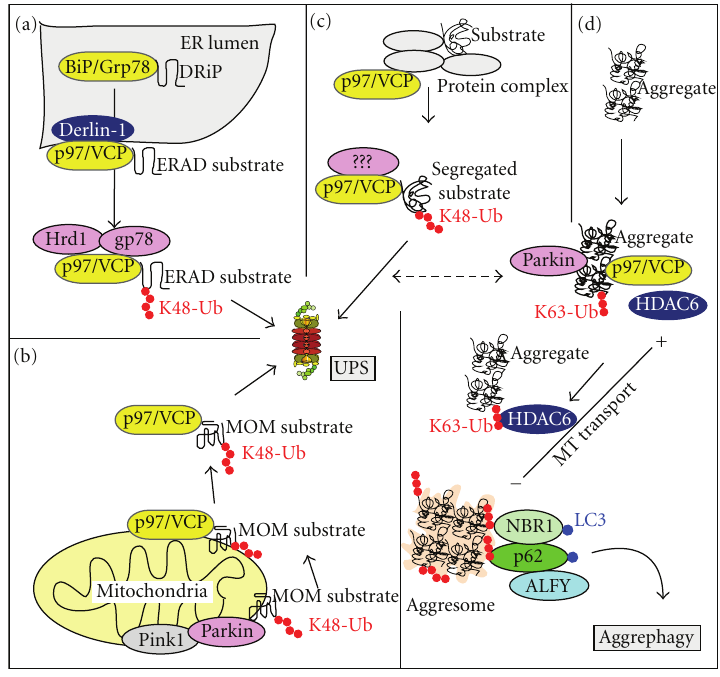
Figure 3: Protein degradation assisted by p97/VCP and HDAC6. (a) Misfolded substrates located in the ER lumen or at the ER membrane are recognized by the ER luminal Hsp70 homologue BiP/Grp78 and degraded by ER-associated degradation (ERAD). A complex of p97/VCP and Derlin-1 mediates the transport of ERAD substrates into the cytoplasm where they are ubiquitinated by E3 ligases such as Hrd1 and gp78 and degraded by the UPS. (b) p97/VCP mediates the segregation of ubiquitinated mitochondrial outer membrane (MOM) substrates into the cytoplasm, where they are degraded by the UPS. (c) p97/VCP mediates the segregation of selected substrates from nuclear or cytoplasmic protein complexes, followed by their degradation by the UPS. (d) p97/VCP is also required for the transport of protein aggregates to the aggresome. This depends on ubiquitination of the aggregate by an E3 ligase such as Parkin, and the delivery of the ubiquitinated aggregate to HDAC6. HDAC6 binds to K63-linked polyubiquitin chains and to dynein, and it is responsible for the transport of ubiquitinated protein aggregates along microtubules to the aggresome. The contents of aggresomes may subsequently be degraded by aggrephagy.